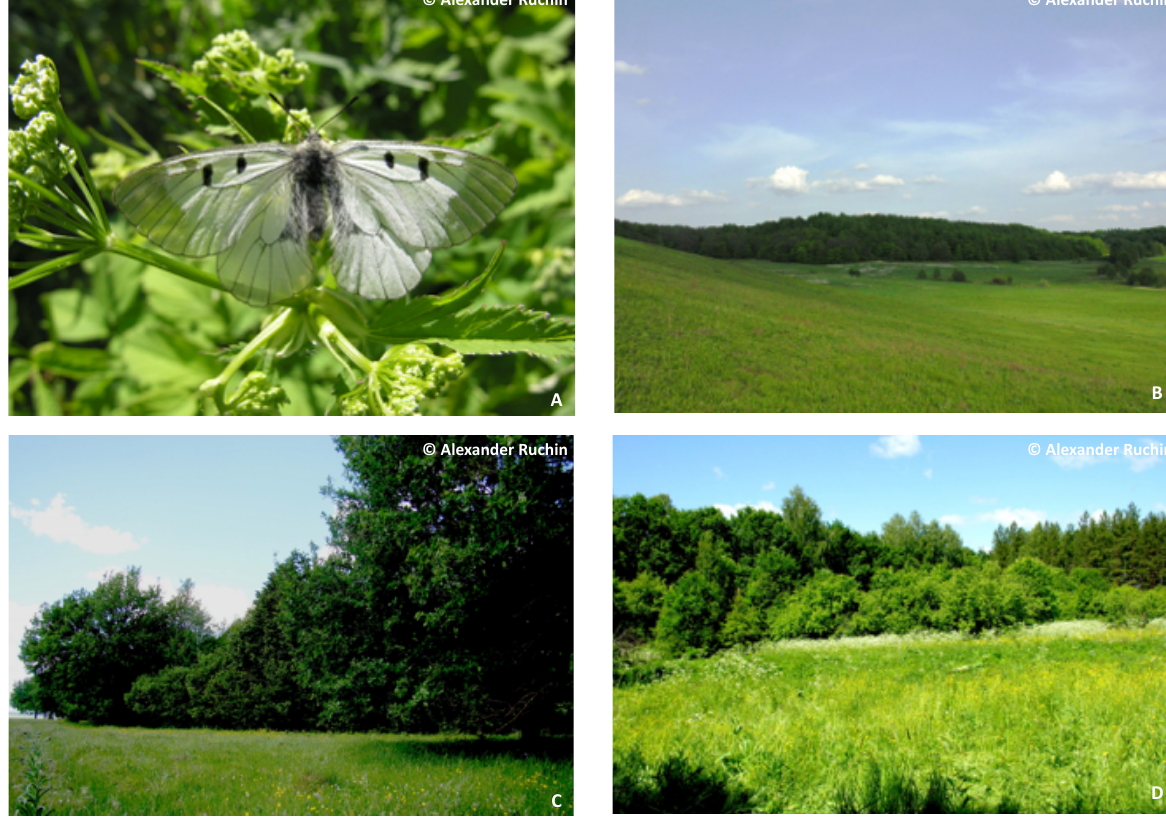
Image 1. Clouded Apollo butterfly and habitats of the species. A - imago (Pajgarm, Ruzaevka District, 17.v.2007); B - biotope (Svetotekhnika, Ardatov District, 18.v.2008); C - biotope (Tarkhany, Temnikov District, 05.vi.2009); D - biotope (Vindrej, Torbeevo District,